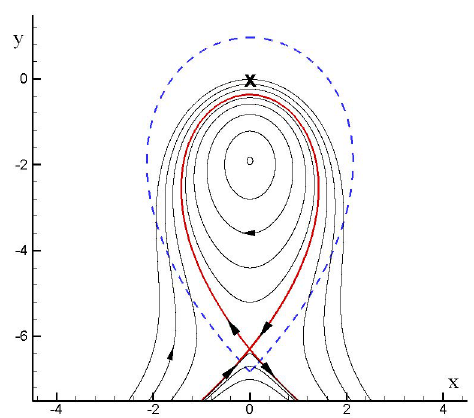
Fig. 2. Topographic vortex streamlines for the upper layer. The red Fig. 1. Azimuthal velocities of the topographic vortex within the Fig. 1: Azimuthal velocities of the topographic vortex within Fig. 2: Topographic vortex stream-lines for the upper layer. Fig. 1: Azimuthal velocities of the topographic vortex within Fig. 2: Topographic vortex stream-lines for the upper layer. curve indicates the separatrix. The dashed blue curve corresponds layers. Curves 1 , 2 , 3 correspond to the upper, middle, and bottom the layers. Curves 1,2,3 correspond to the upper, middle, The red curve indicates the separatrix. The dashed blue curve the layers. Curves 1,2,3 correspond to the upper, middle, The red curve indicates the separatrix. The dashed blue curve to the middle-layer separatrix. The cross marks the delta-function layer, respectively. The horizontal straight line indicates constant and bottom layer, respectively. The horizontal straight line corresponds to the middle layer separatrix. The cross marks topography position, ( 0 , 0 ) and bottom layer, respectively. The horizontal straight line corresponds to the middle layer separatrix. The cross marks background velocity value W 0 = 0 . 2 π . = 0 . 2 π . indicates constant background velocity value W the delta-function topography position, (0 , 0) . = 0 . 2 π . indicates constant background velocity value W the delta-function topography position, (0 , 0) . 0 0